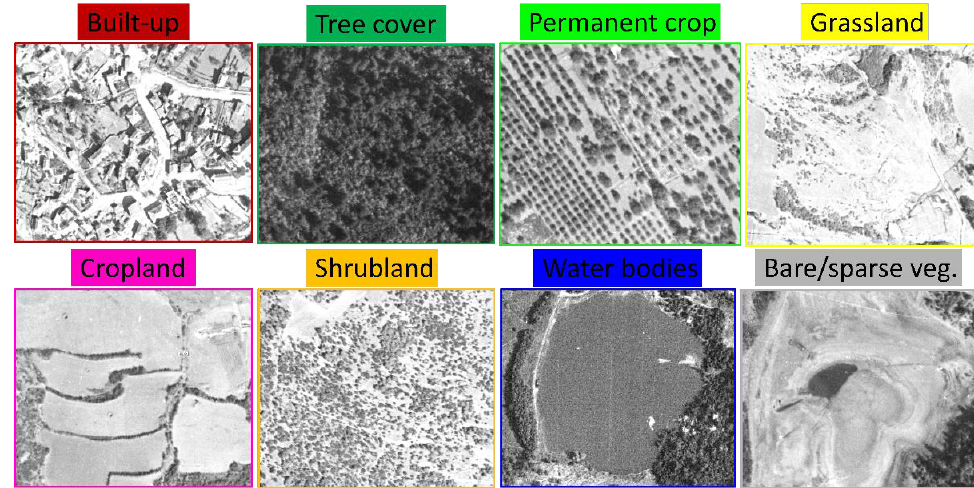
Figure 13. Examples representing the land cover classes.